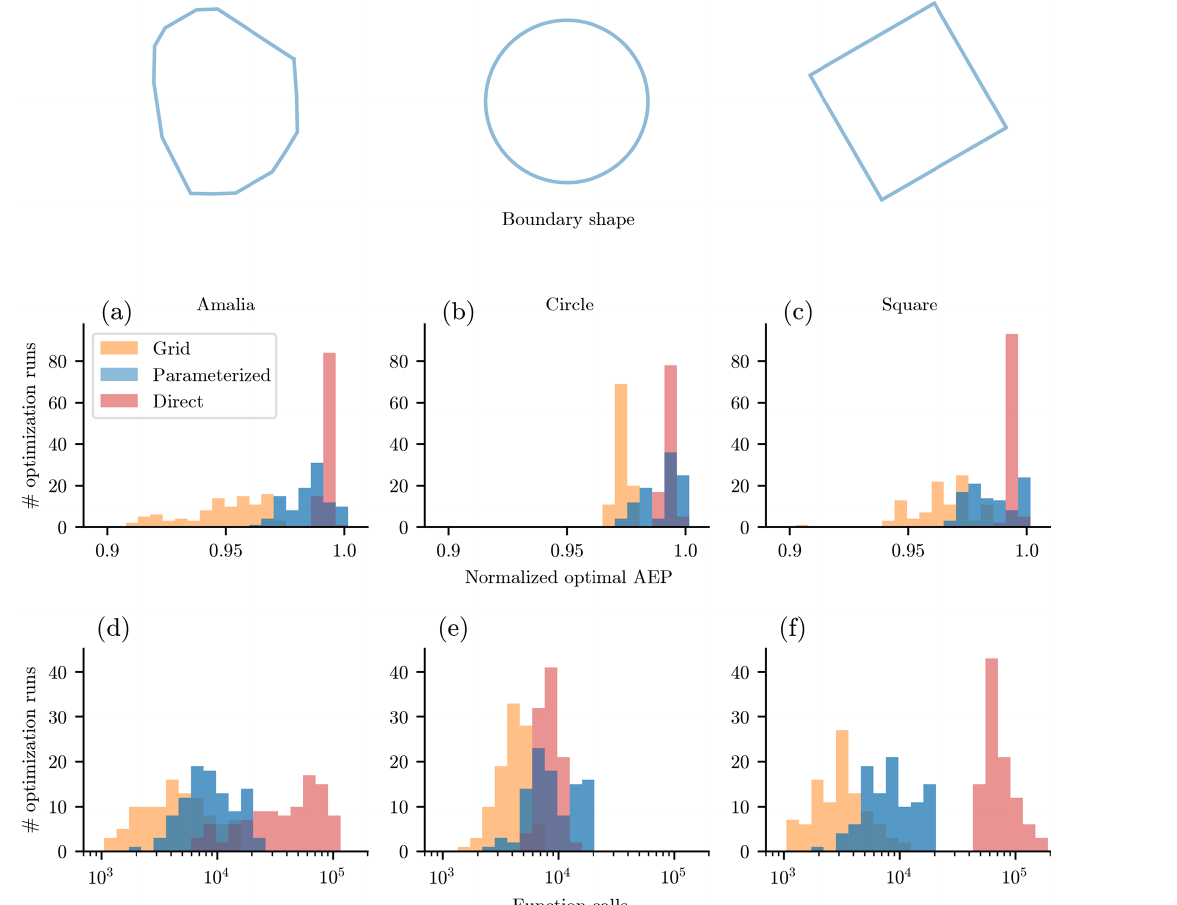
Figure 12. Results from 100 randomly initialize optimizations for wind farms with varied wind farm boundaries and 100 wind turbines. The average turbine spacing was 4 rotor diameters, and the wind rose was from North Island, California. Shown are results using the grid turbine parameterization, our new boundary-grid parameterization, and direct optimization. The optimal annual energy production distribution achieved for each of the optimization runs, in wind farms with varied boundary shapes. (a) Princess Amalia wind farm boundary. (b) Circular wind farm. (c) Square wind farm. The number of function calls required to converge for each of the optimization runs, in wind farms with varied boundary shapes. (d) Princess Amalia wind farm boundary. (e) Circular wind farm. (f) Square wind